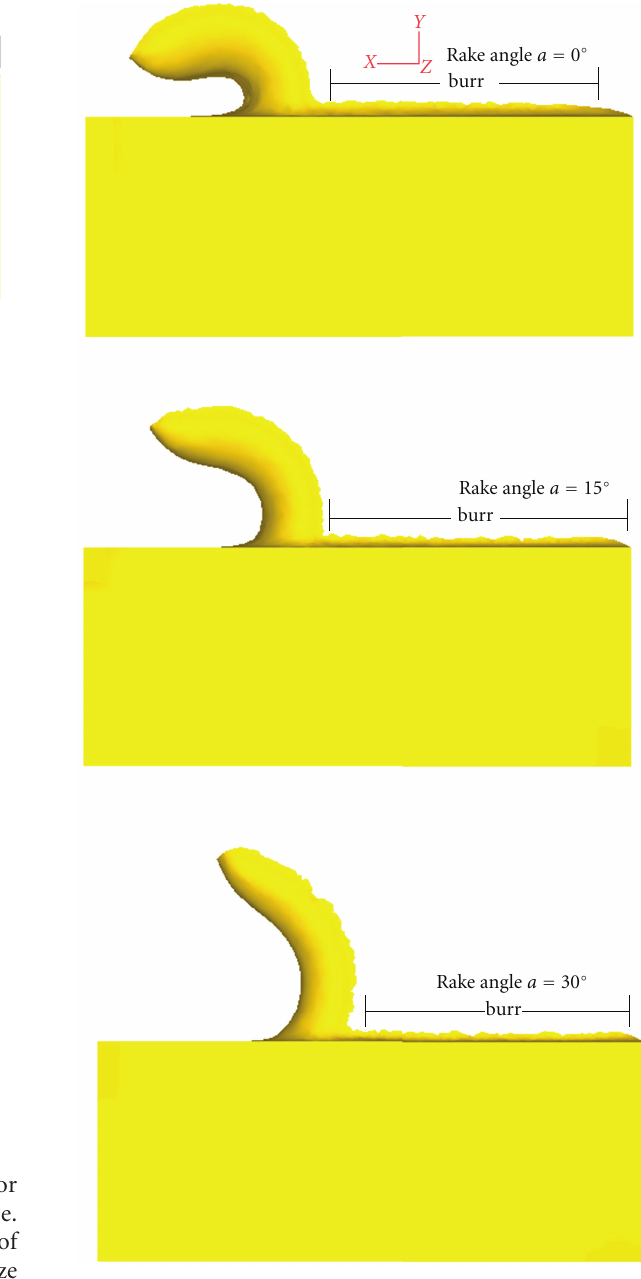
Figure 9: Burr profiles for di ff erent rake